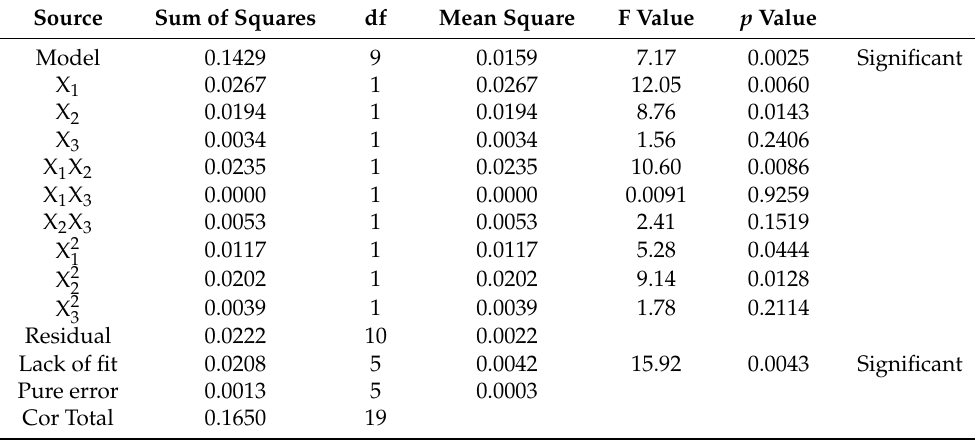
Table 4. ANOVA for model and respective model term: Diametric compressing